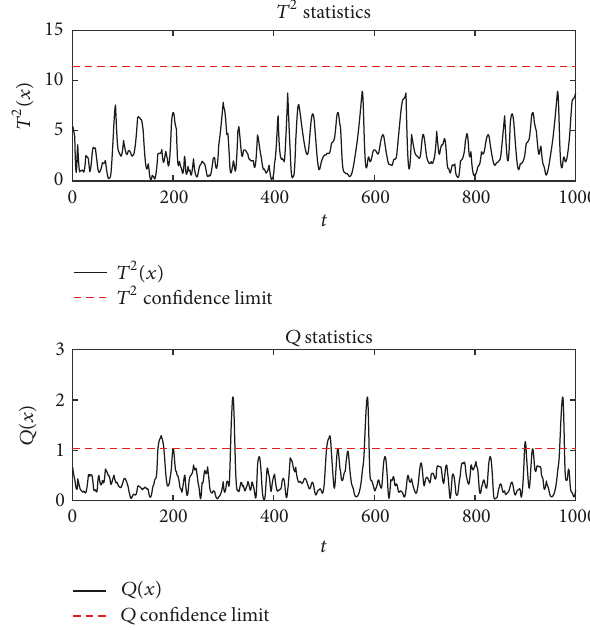
Figure 4: 𝑄 and 𝑇 2 statistics with preprocessed